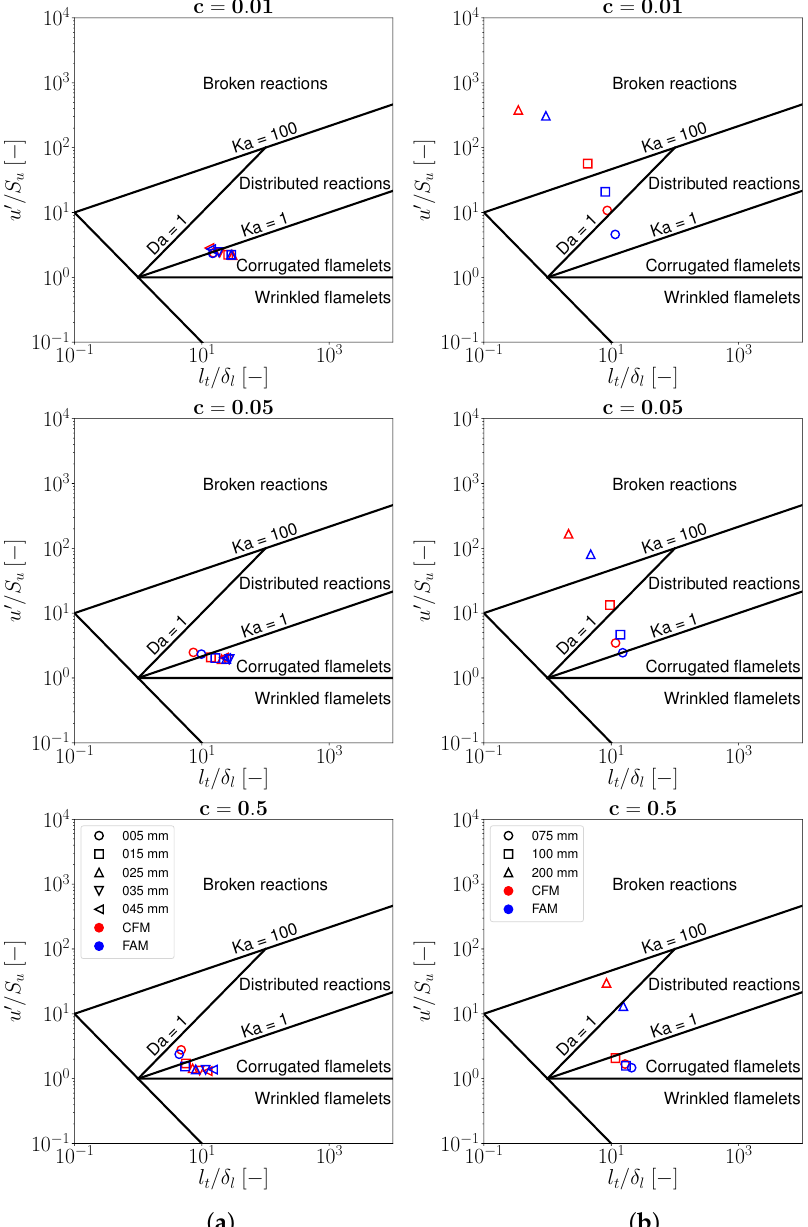
Figure 7. Case A-r: numerical flame regimes achieved with CFM (red) and FAM (blue) at different axial positions y , evaluated at three values of normalized progress variable: c = 0.5, c = 0.05 and c = 0.01, from bottom to top line. Column ( a ): 5 mm